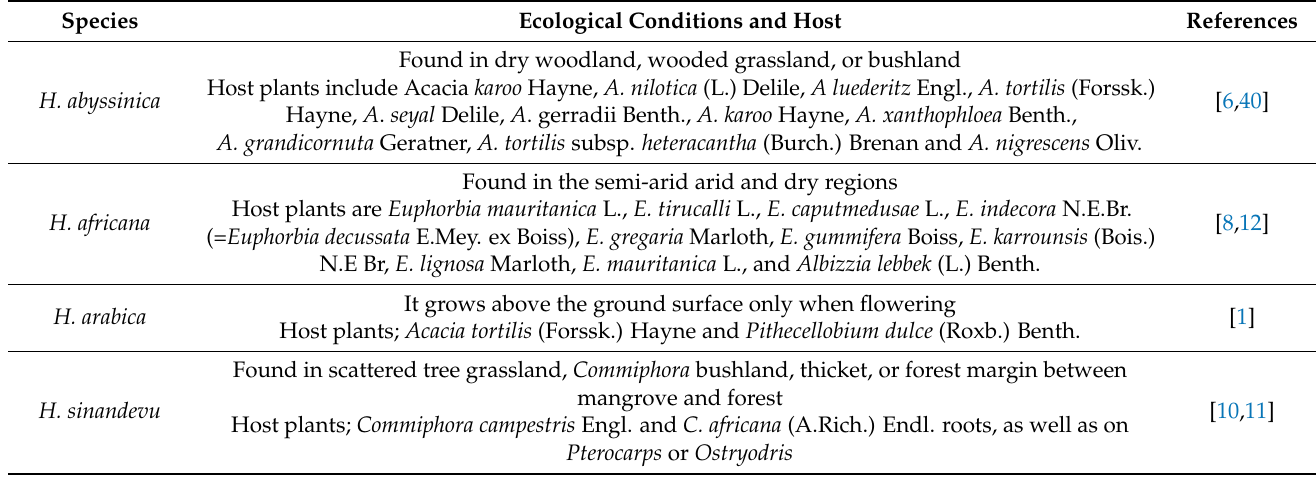
Table 1. Ecological conditions and